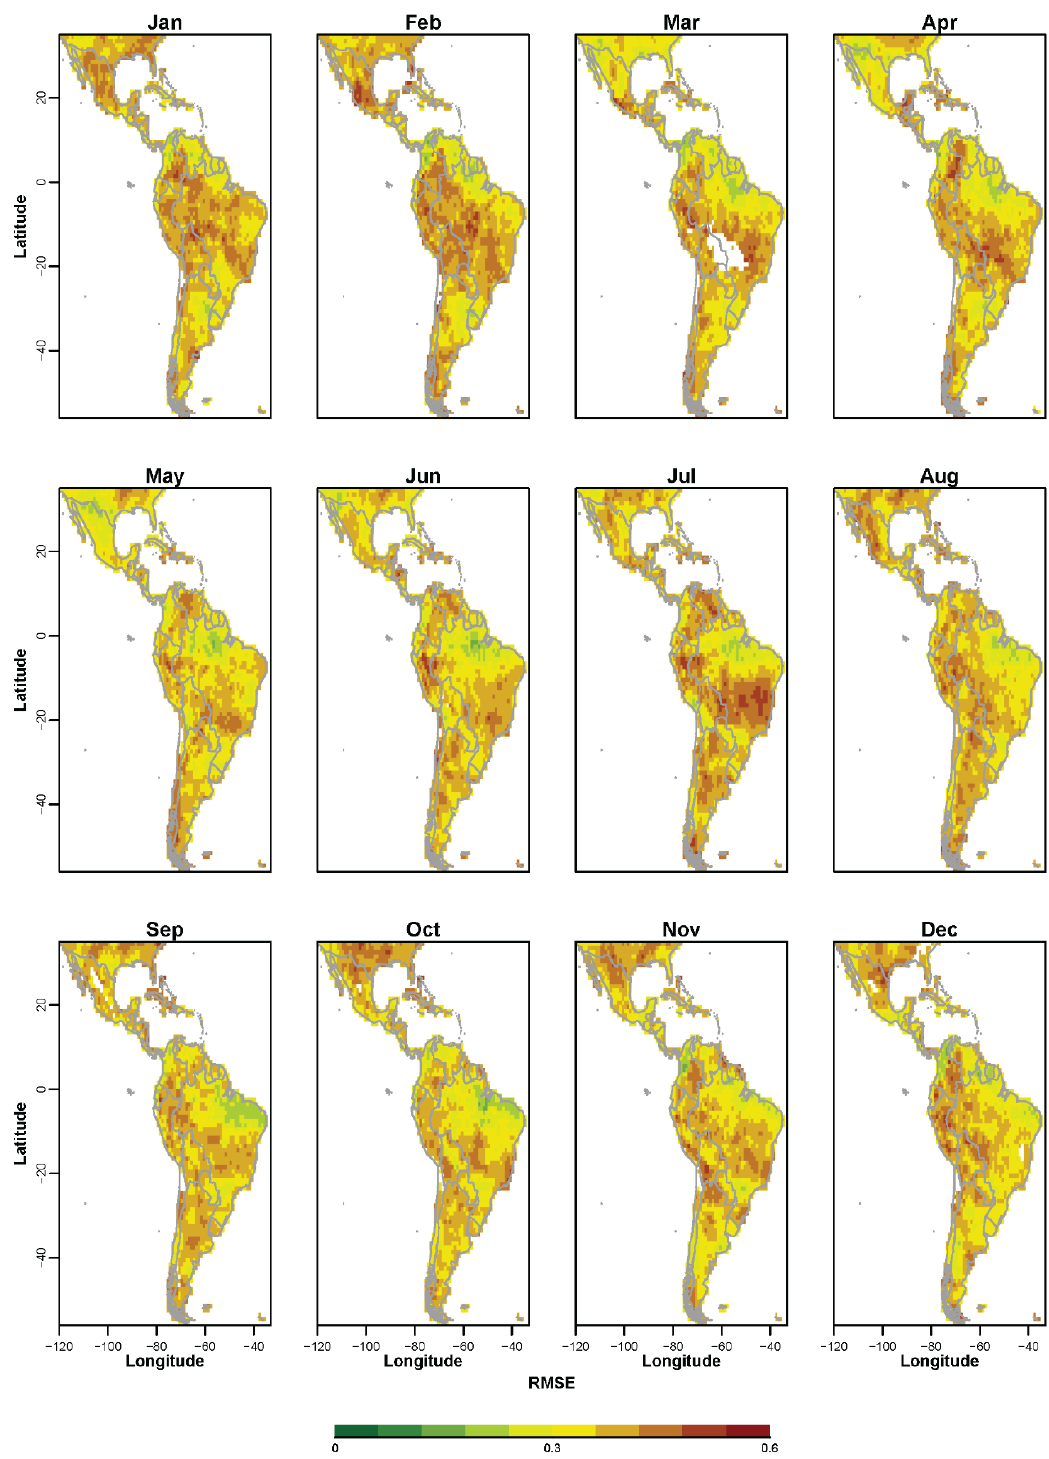
Figure A3. RMSE between the observed and forecast SPI6 at 6-month lead time (mean of the ensemble) for the hindcast period (1981–2010). Values in difference of percentile magnitude are indicated in the color bar.